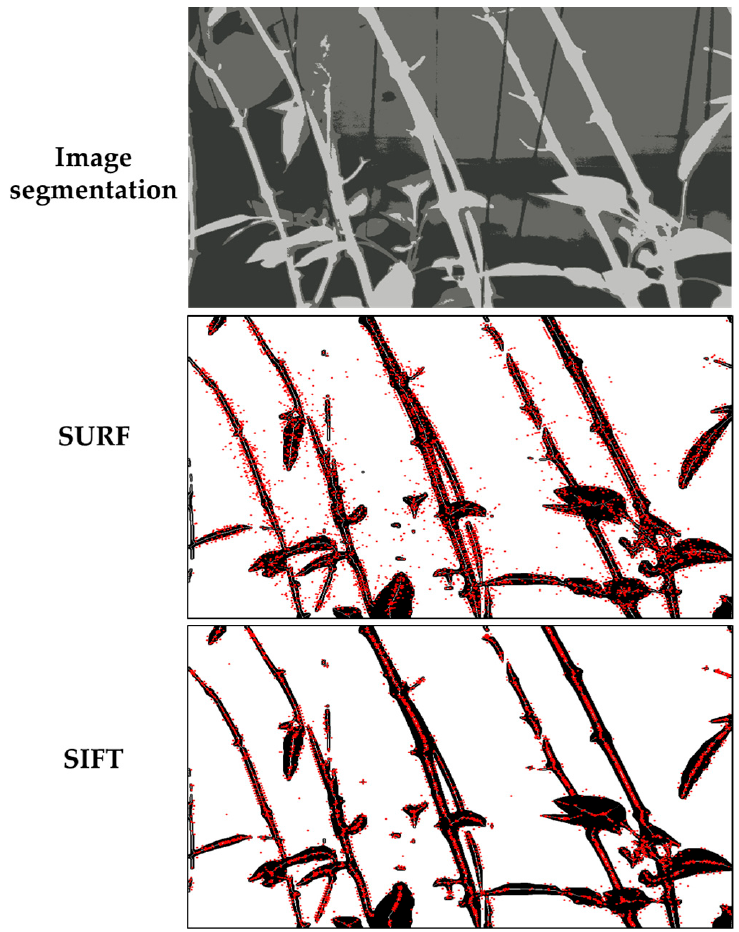
Figure 9. The image of local feature extraction processes using skeletonization, SIFT, and SURF.